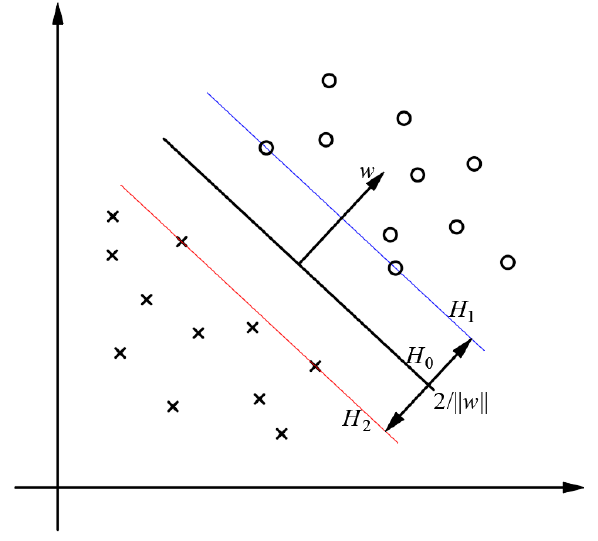
Figure 2. Schematic diagram of the linear separable support vector machine.